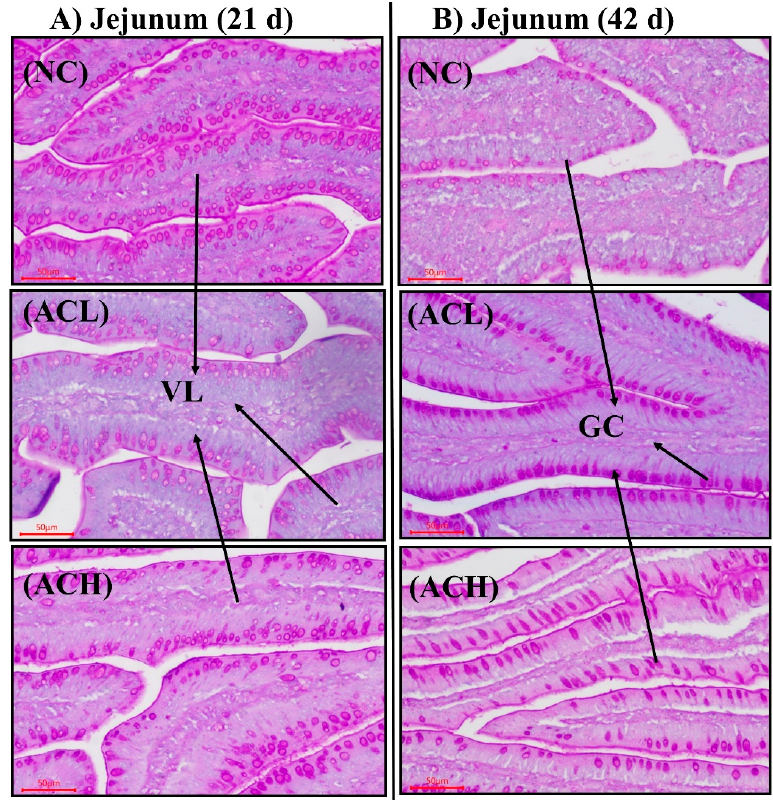
Figure 2. Jejunum villus morphology. Intestinal specimens ( n = 6) were collected at 21 d ( A ) and 42 d ( B ); normal corn diet (NC); low aging corn (ACL); high aging corn (ACH). VH = villus height; GC = goblet cell.